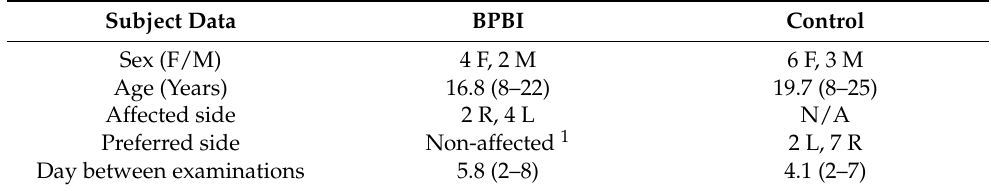
Table 1. Description of participants for Part II of this study (Test–retest and interrater